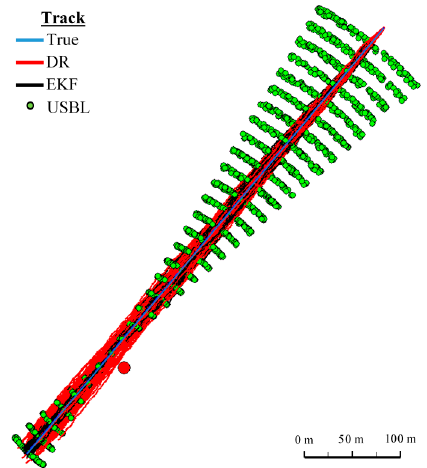
Figure 24. Determined route (one hundred passages).